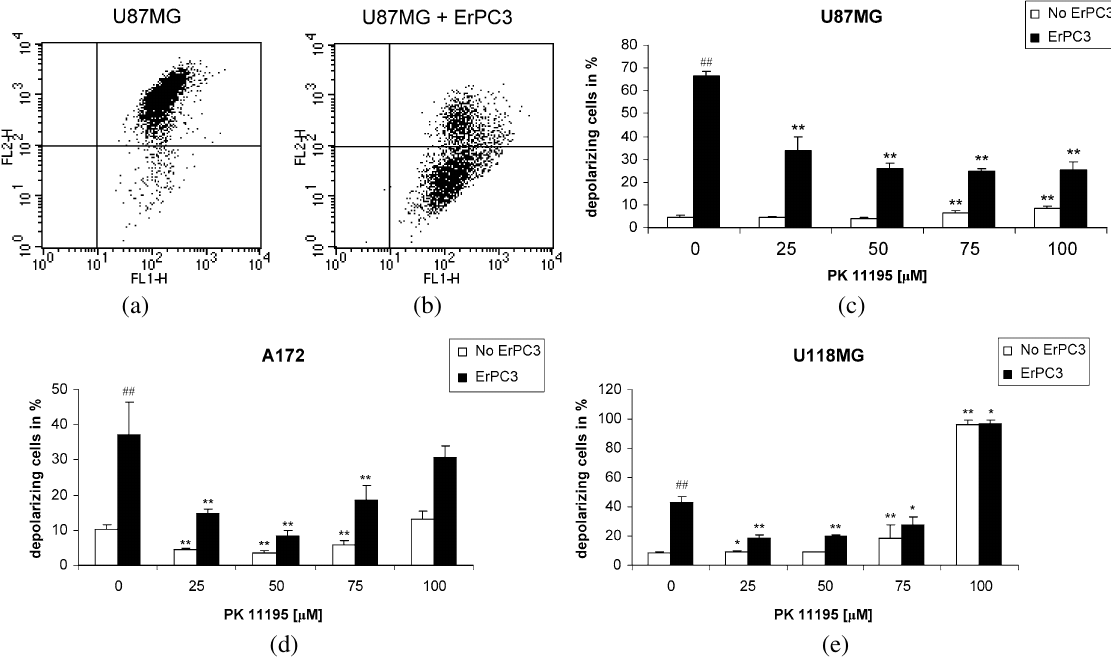
Fig. 6. Effects of ErPC3 and PK 11195 on the inner mitochondrial membrane potential ( Δ ψ m ) in the glioblastoma cell lines U87MG, A172 and U118MG using the dye JC-1. (a) and (b) The FACS patterns of U87MG cells labeled with JC-1 in the absence (a) or presence (b) of ErPC3 (45 µM) are shown as examples. Cells with polarized mitochondria are found in the upper right (UR) quadrant of the plots, corresponding to high emission of fluorescence at both the 590 nm (FL2-H, orange-red) and 527 nm (FL1-H, green) wavelengths. After ErPC3 treatment, membrane depolarization becomes evident as a decrease in the 590 nm signal and an increase in the 527 nm signal, in the lower right (LR) quadrant of (b). In (c), (d) and (e), U87MG, A172 and U118MG were treated with ErPC3 (45, 30, 15 µM, respectively) and/or PK 11195 at increasing concentrations for 24 h and Δ ψ m was evaluated as illustrated with (a) and (b). Each column represents the mean values of cell percentages derived from each time 6 independent experiments in the LR quadrant of the Δ ψ m analysis plot (depolarized mitochondria). In all three cell lines co-treatment with PK 11195 (at concentrations of 25, 50 and 75 µM) reduced the incidence of Δ ψ m collapse otherwise induced by ErPC3 itself. ## p < 0 . 01 when ErPC3 treatment is compared with no ErPC3 treatment (with PK 11195 treatment of 0 µM). ∗ p < 0 . 05 and ∗∗ p < 0 . 01 for the various co-treatments of PK 11195 with ErPC3 in comparison to 0 µM PK 11195 (with ErPC3) of the cell lines in